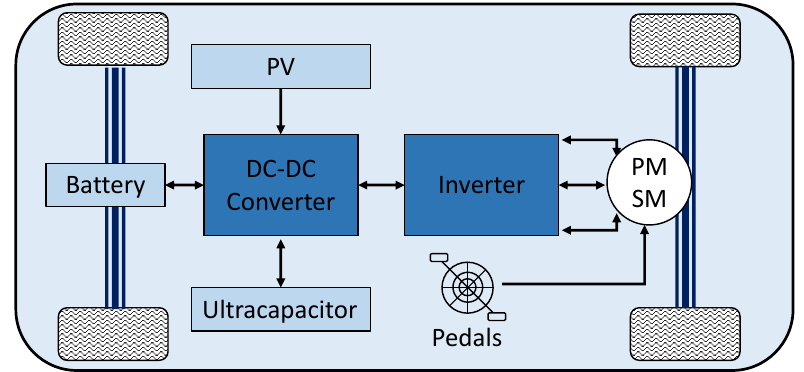
Figure 1. Diagram of the electric vehicle (EV) considered in this investigation.